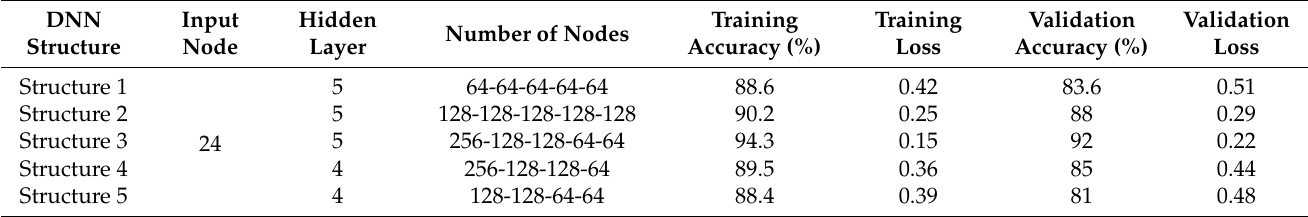
Table 5. Five DNN Table 5. Five DNN structures.